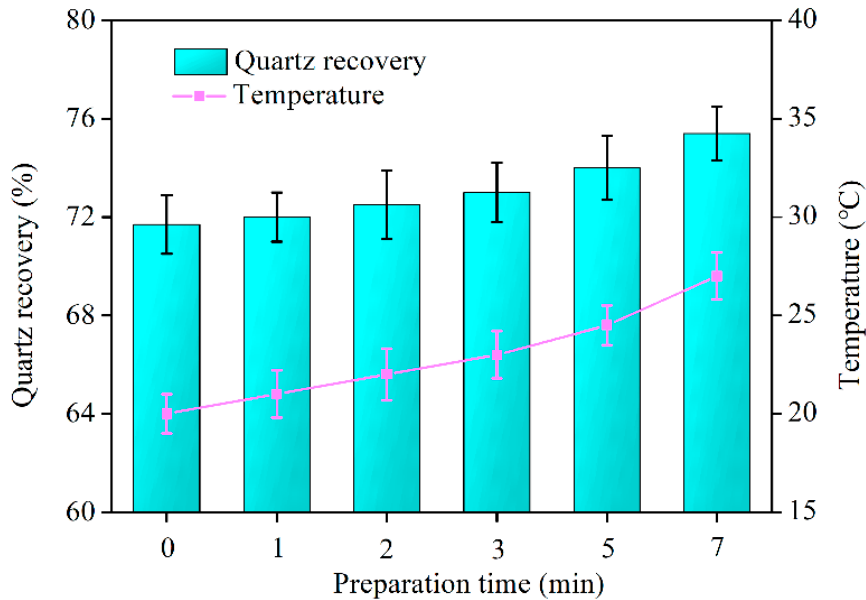
Figure 15. Effect of water temperature on flotation performance.